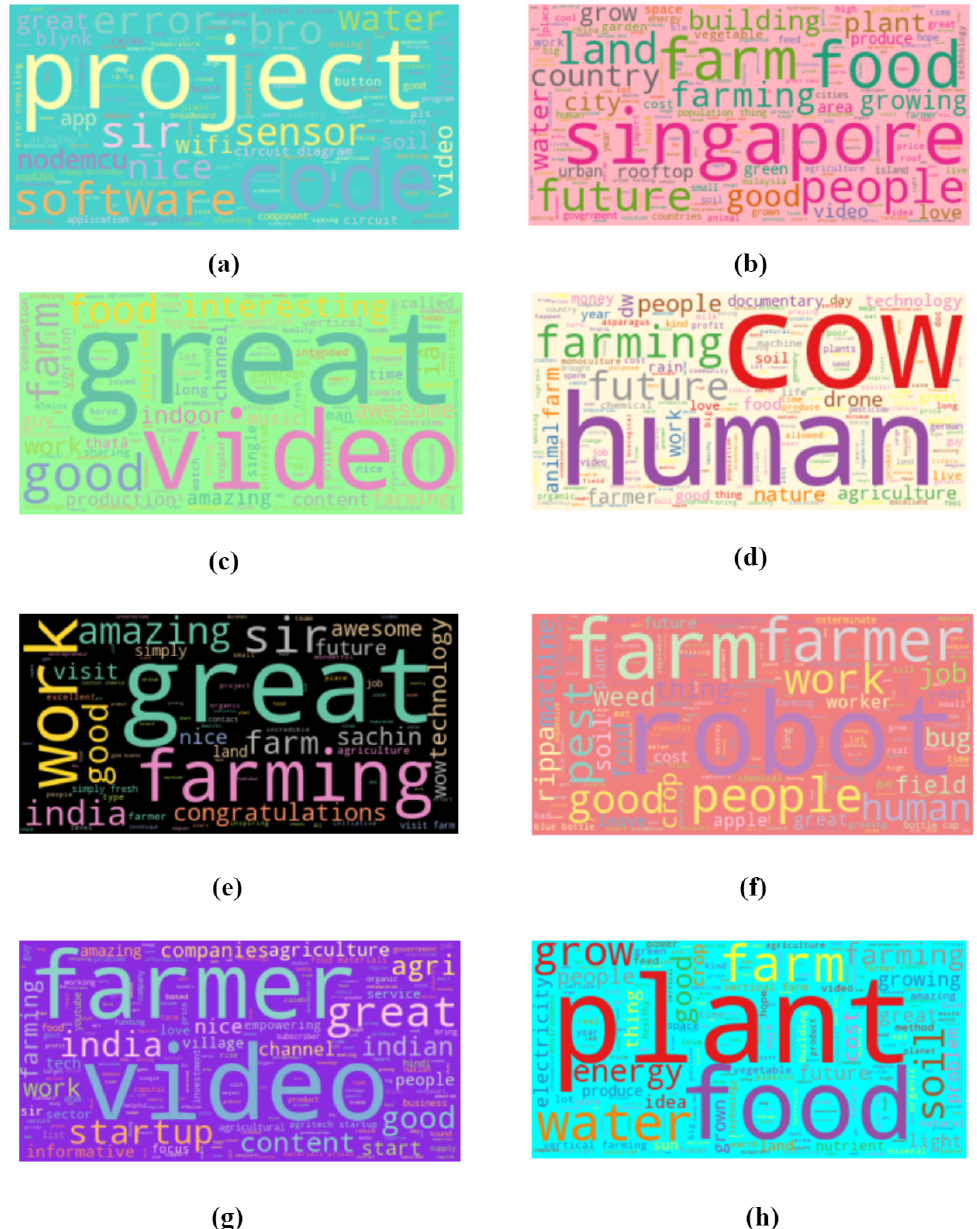
Figure 9. Word clouds for videos no. 9–16 corresponding ( a – h )